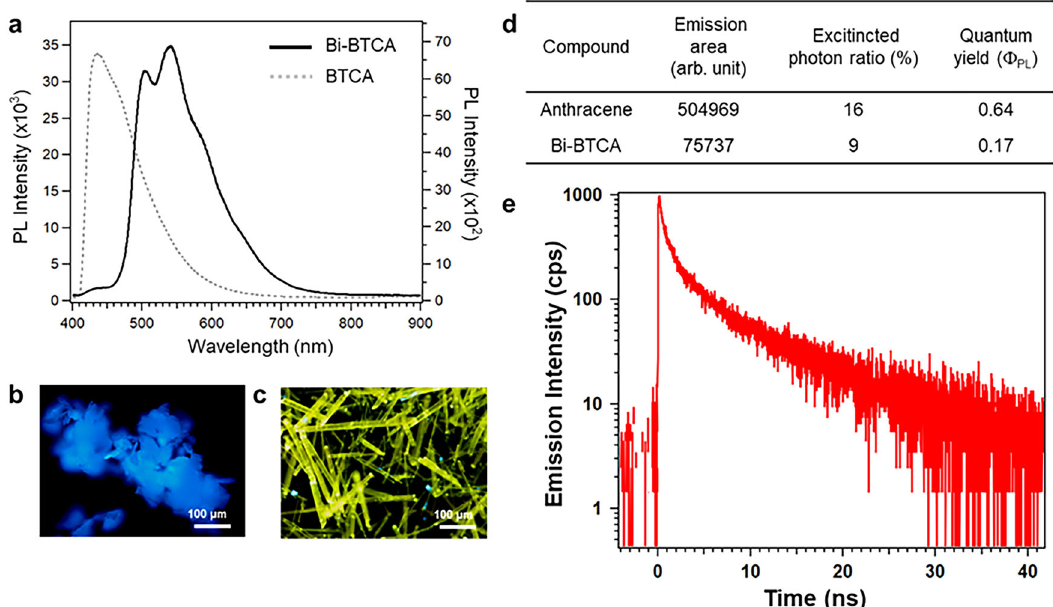
Fig. 2 Photophysical characterization of Bi-BTCA. a Steady-state PL spectra of BTCA (dotted line, left axis) and Bi-BTCA crystal (solid line, right axis). b BTCA and c Bi-BTCA crystals optical images taken during exposure to a UV (365 nm) lamp. d Photoluminescence quantum yields obtained in single crystals. e TRPL of Bi-BTCA (red) crystal detected at 500 nm after photoexcitation at 380 nm. Time resolution was 75